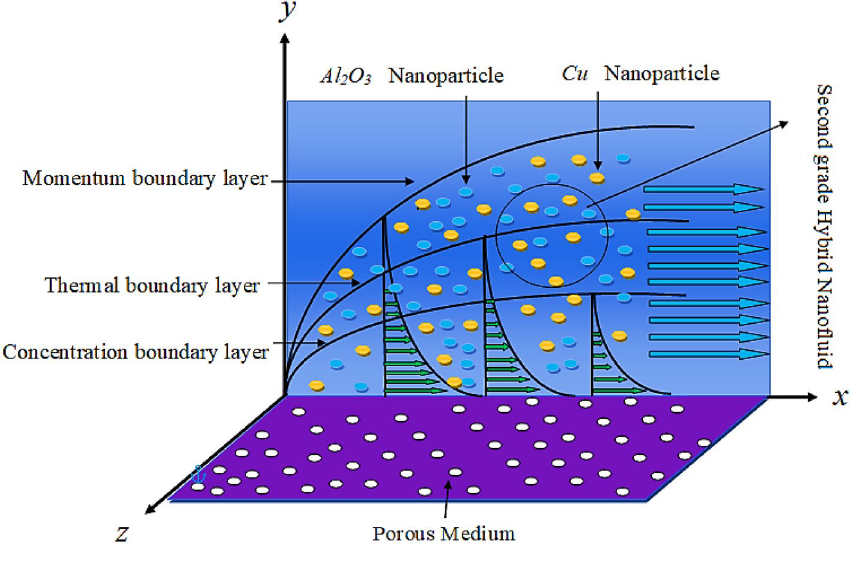
Figure 1. Geometry of the